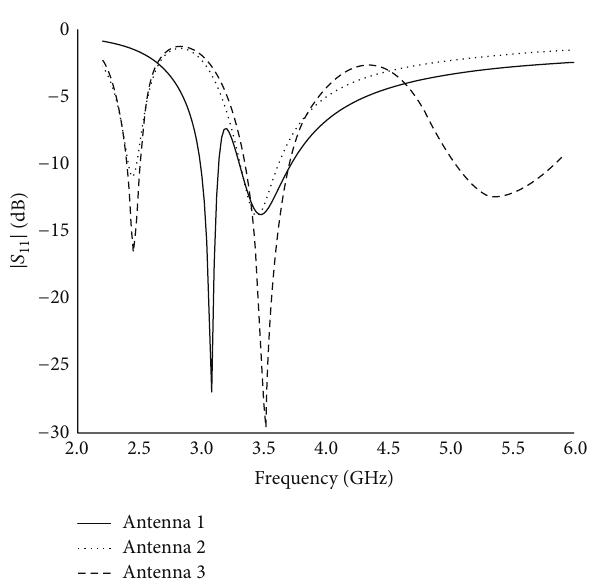
Figure 1: Geometry of Antenna 1, Antenna 2, and Antenna 3.